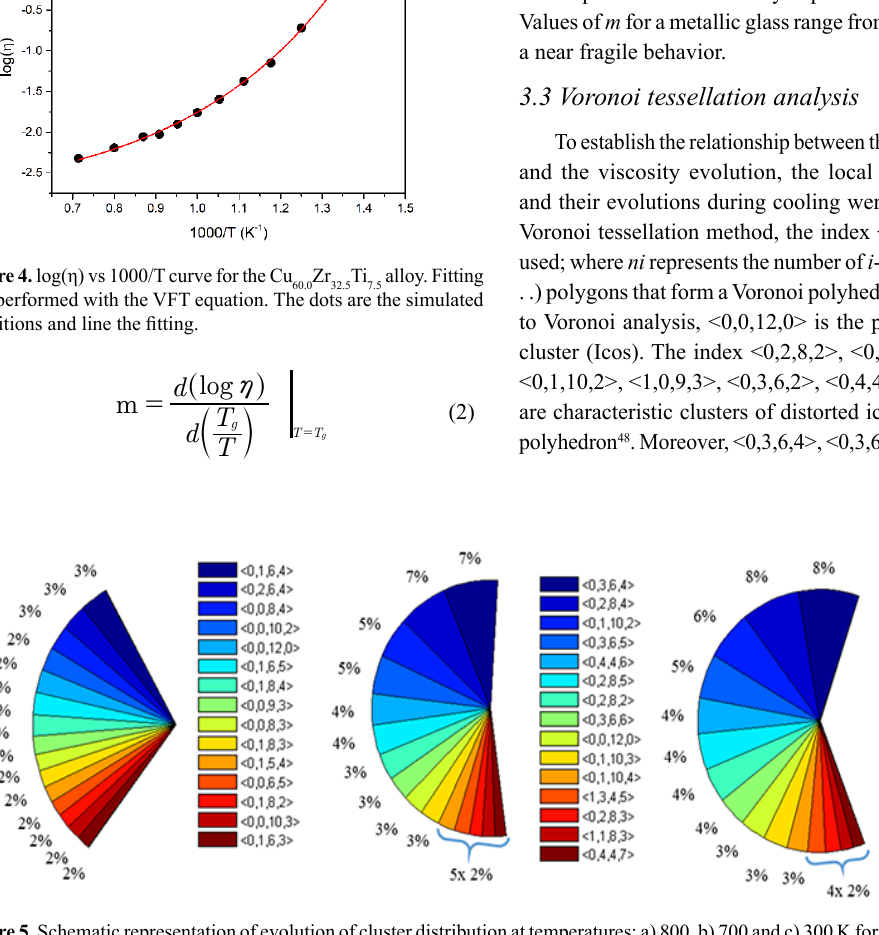
Figure 5. Schematic representation of evolution of cluster distribution at temperatures: a) 800, b) 700 and c) 300 K for Cu